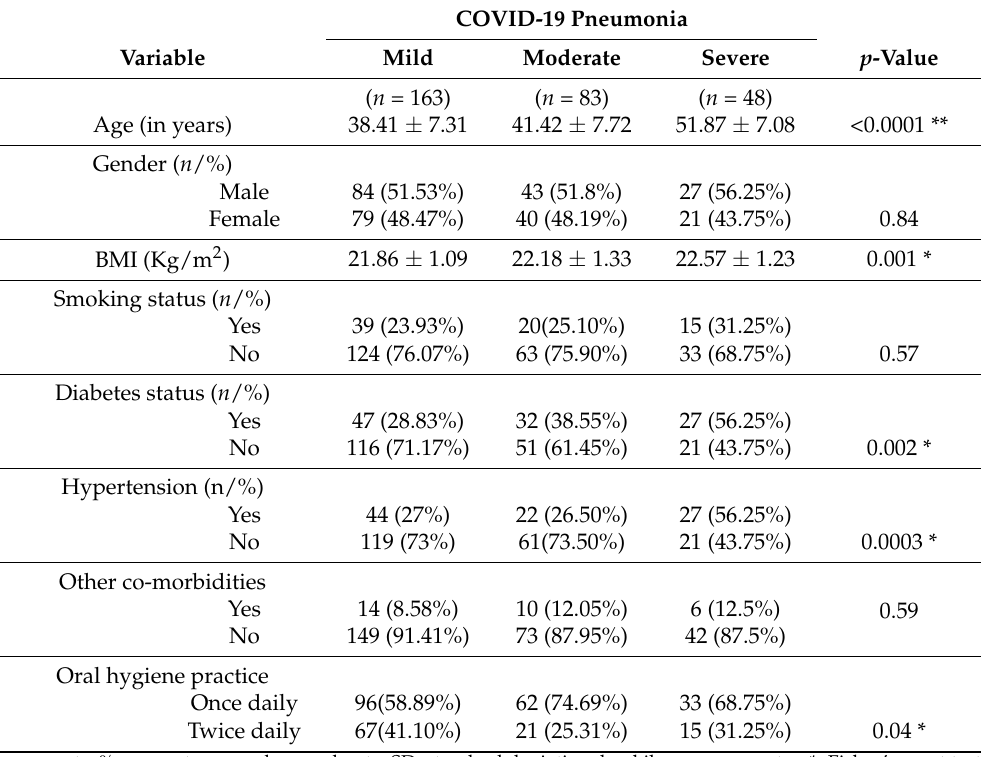
Table 1. Participant details among the three COVID-19 pneumonia groups.